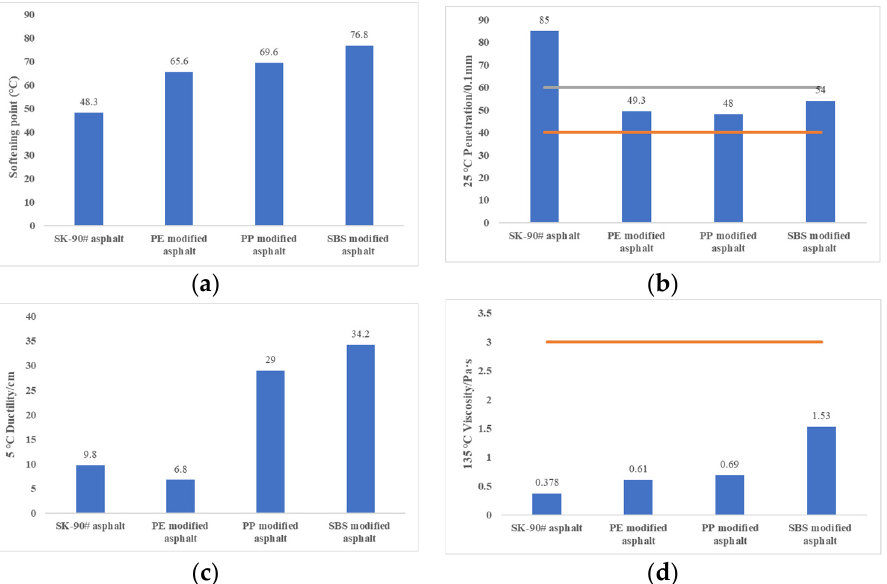
Figure 5. Comparative analysis of matrix asphalt and SBS modified asphalt. ( a ) Softening point. ( b ) Penetration. ( c ) Ductility. ( d ) Viscosity.